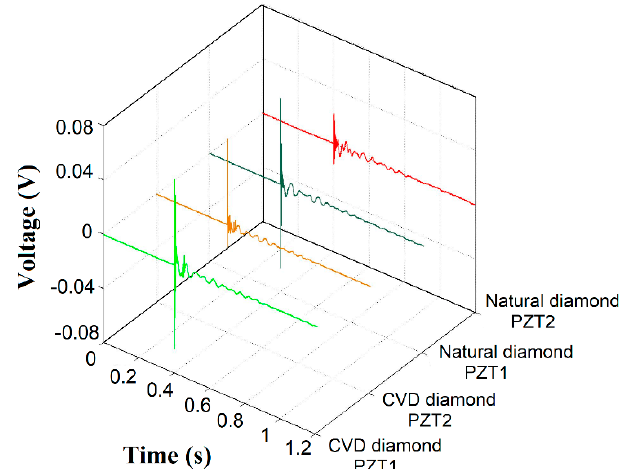
Figure 3. PLB results: Voltage signals.